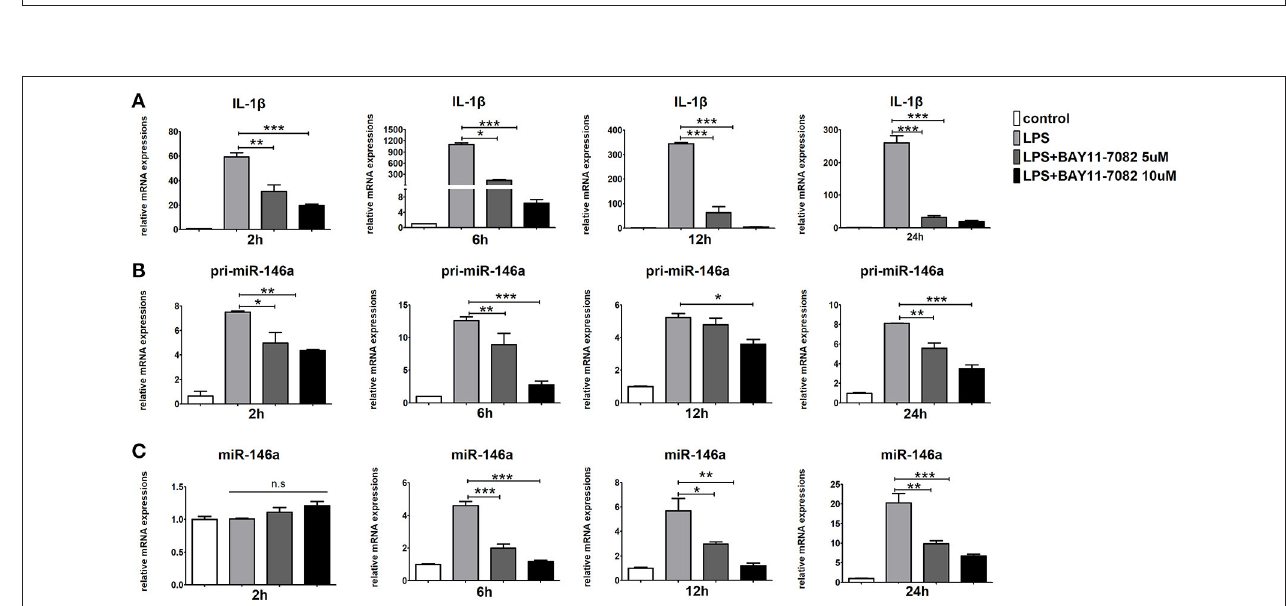
FIGURE 6 | GSKJ4 restrains the recruitment of JMJD3 to the promoter region of miR-146a. Raw264.7 cells were pre-treated with or without GSKJ4 (4 µ mol/L) for 1h, followed by stimulation with LPS (100ng/mL) for 24h. (A,B) ChIP assay was performed using anti-JMJD3, anti-trimethyl H3K27 (H3K27me3), and IgG. The occupancy of each protein was determined with quantitative PCR at the gene promoter region encompassing the JMJD3 binding site. ChIP assay using normal IgG was performed as a negative control. Data are shown as mean ± SEM ( n = 3). * P < 0.05; ** P < 0.01; *** P < 0.001.